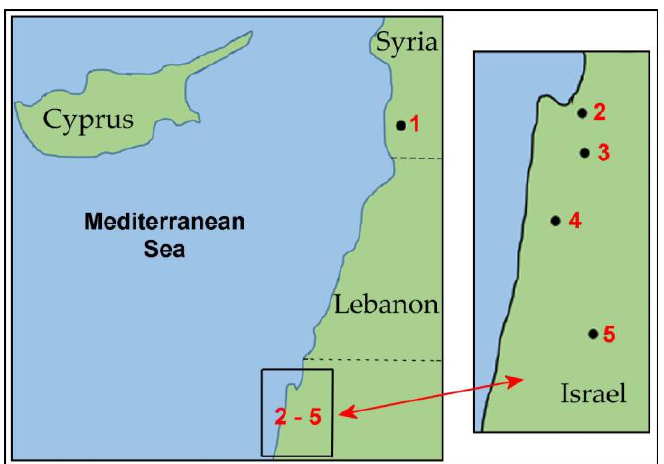
Figure 1. Geographical location of the studied populations of Ae. speltoides . Collection sites for Ae. speltoides : 1 - Tartus; 2 – Kishon; 3 – Technion; 4 – Ramat haNadiv; 5 – Katzir.